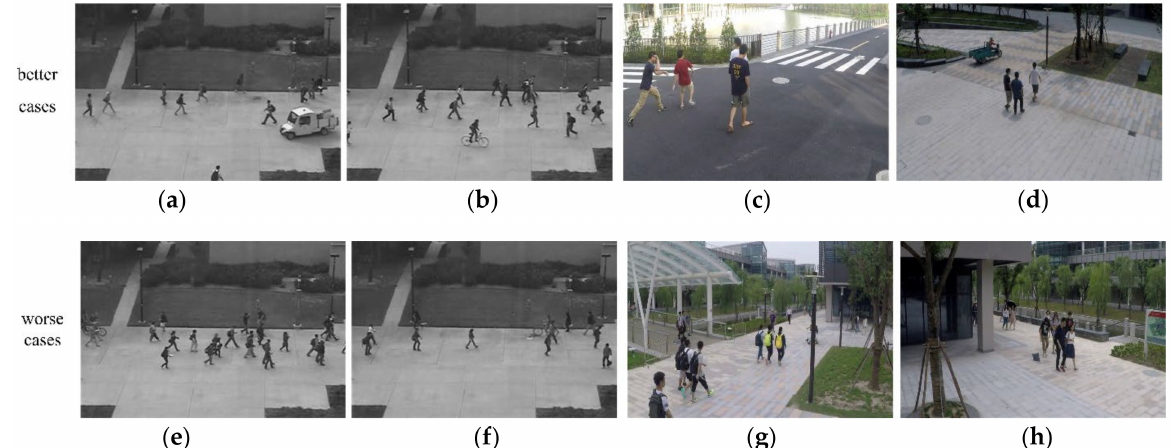
Figure 8. Examples of better and worse abnormality detection results. ( a ) cars on the sidewalk. ( b ) cyclists on the sidewalk. ( c ) intense movements. ( d ) cars on the sidewalk. ( e ) occluded, cyclists on the sidewalk ( f ) poorly illuminated, cyclists on the sidewalk. ( g ) occluded, scooters on the sidewalk. ( h ) lost